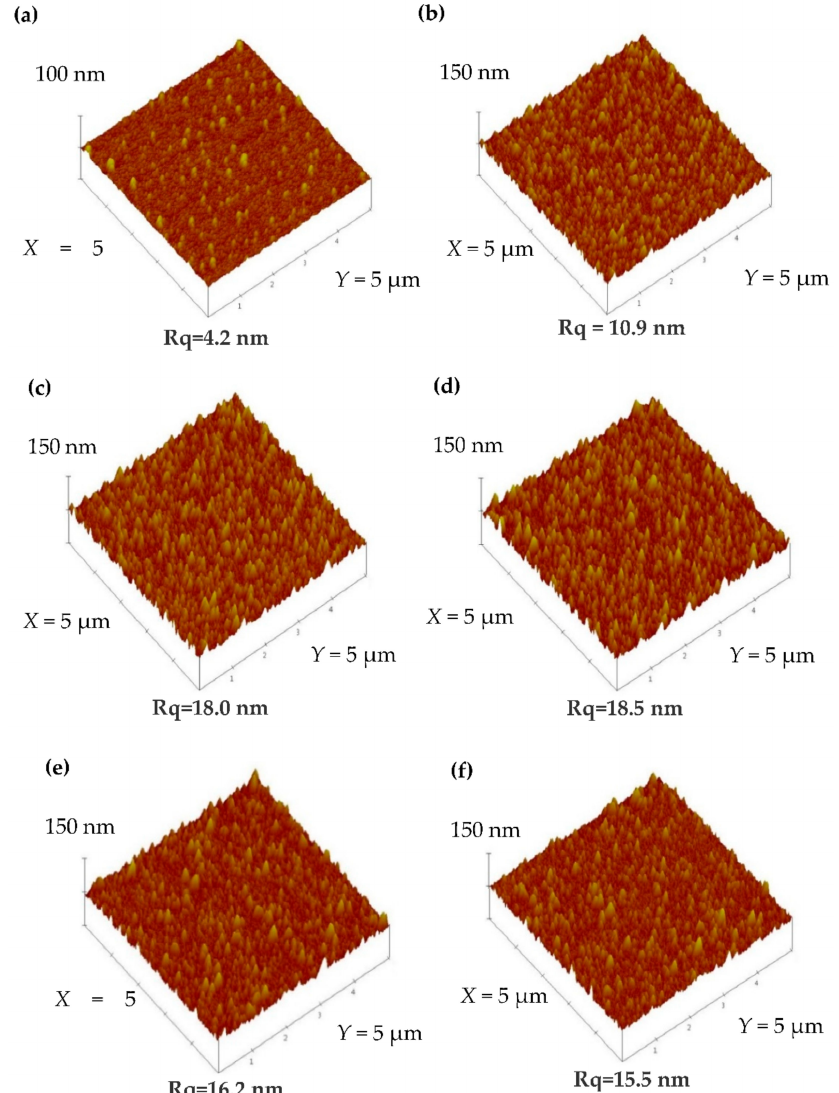
Figure 4. Surface roughness of ( a ) the TiO x film, ( b ) the as-deposited TiO x /Ag structure, and the structures annealed at ( c ) 300, ( d ) 400, ( e ) 500, and ( f ) 600 ◦ C under nitrogen ambient for 1 min, examined by